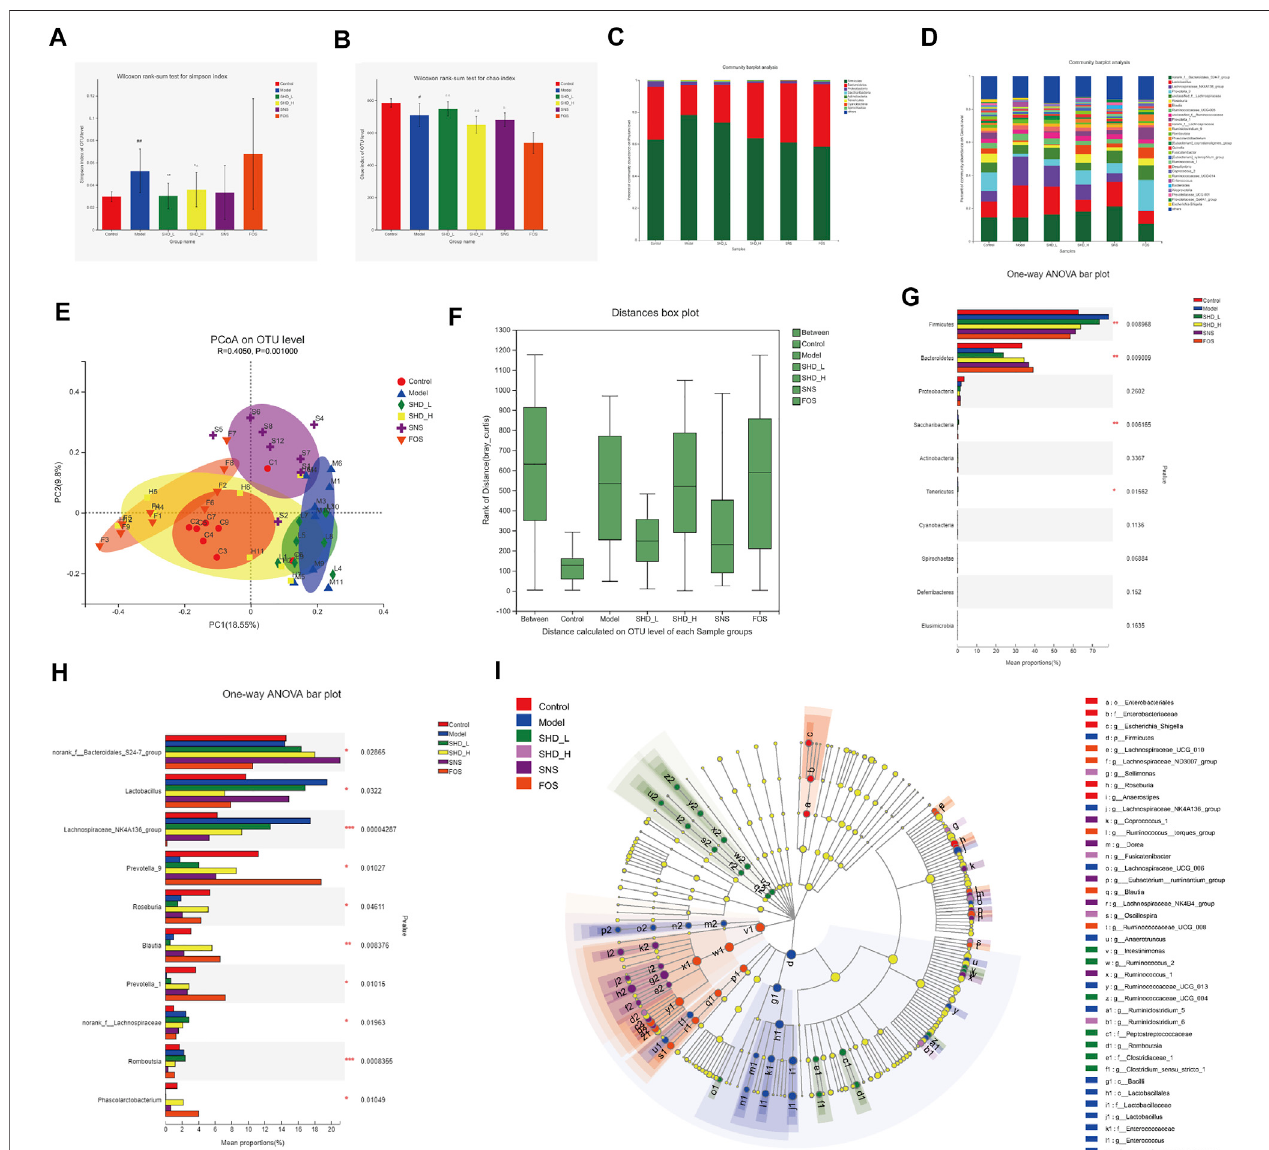
FIGURE 5 | SHD remodels the cecal microbiota dysbiosis of CUS model rats. (A) Effect of SHD on the alpha diversity of the cecal contents from the rats in each group( n (cid:2) 7 – 8),theSimpsonindexoftheoperationaltaxonomicunit(OTU)level. (B) EffectofSHDonthealphadiversityofthececalcontentsfromtheratsineachgroup ( n (cid:2) 7 – 8), the Chao index of the OTU level. (C) Effect of SHD on the microbiota abundance (phylum level) in the rats in each group ( n (cid:2) 7 – 8). (D) Effect of SHD on the microbiotaabundance(genuslevel)intheratsineachgroup( n (cid:2) 7 – 8). (E) Aprincipalcoordinatesanalysis(PCoA)mapbasedontheunweightedUnifracmatrixand Bray – Curtis dissimilarity. (F) An analysis of similarities of the distance calculated at the OTU level for each group. (G) Comparison of the relative microbiota abundance (phylumlevel)inthececalcontentsfromtheratsineachgroup( n (cid:2) 7 – 8). (H) Comparisonoftherelativemicrobiotaabundance(genuslevel)inthececalcontentsfromthe ratsineachgroup( n (cid:2) 7 – 8). (I) Alineardiscriminantanalysis(LDA)coupledwitheffectsizemeasurement(LEfSe)ofthedifferentmicrobiota inthececalcontentsfromthe rats in each group, from thephylum level tothe genus level (LDA score 3). The dataare expressed asthe mean ± SD. p Indicatesstatistical signi fi cance ( p 0.01 < p ≤ 0.05, pp 0.001 < p ≤ 0.01, ppp p ≤